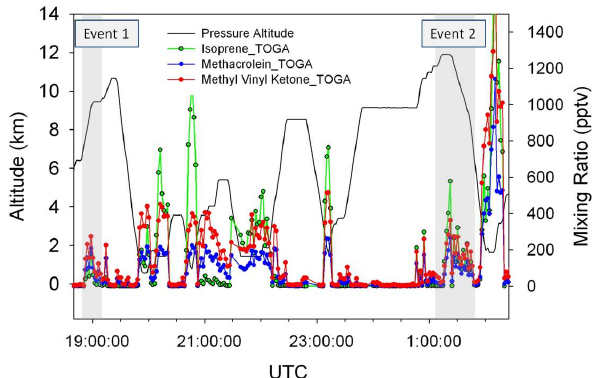
Fig. 3. Time series plot of altitude, isoprene, and first generation reaction products methacrolein and methyl vinyl ketone during the 4 July 2008 ARCTAS DC-8 flight. Events 1 and 2 are